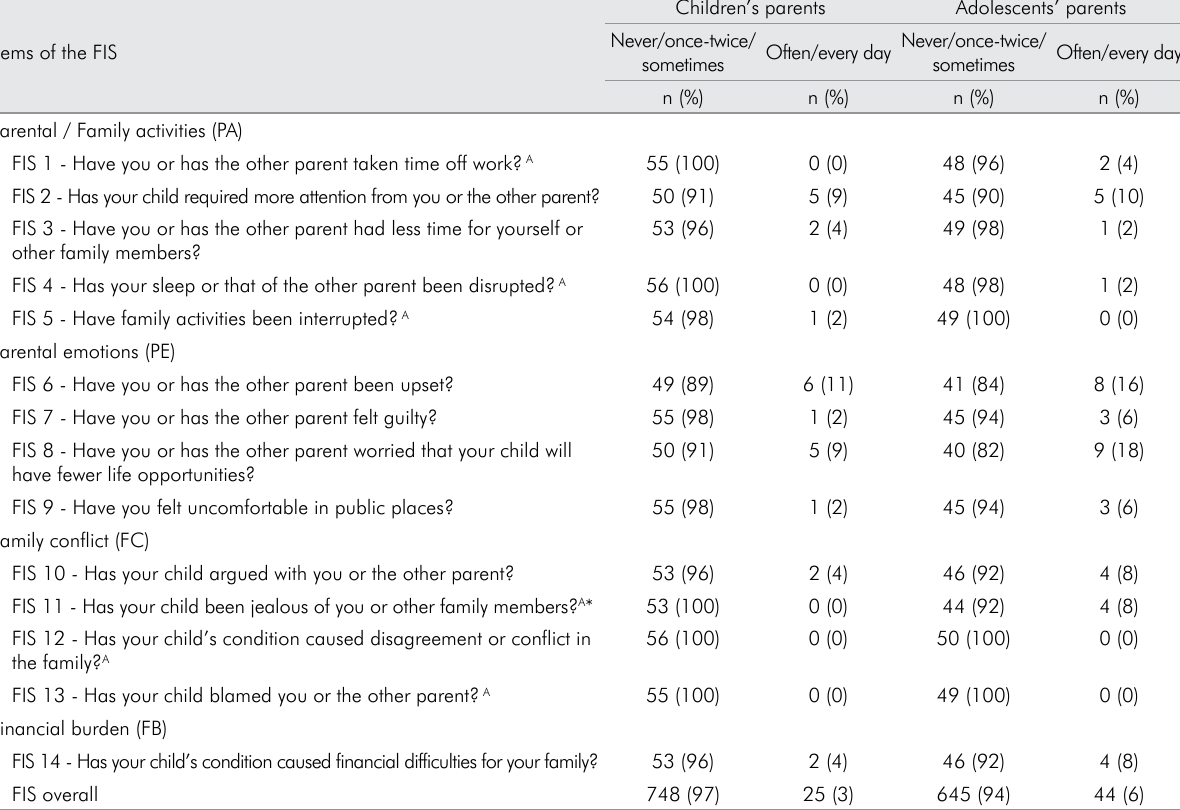
Table 1. Parents’ responses to the FIS (Family Impact Scale) on the survey.